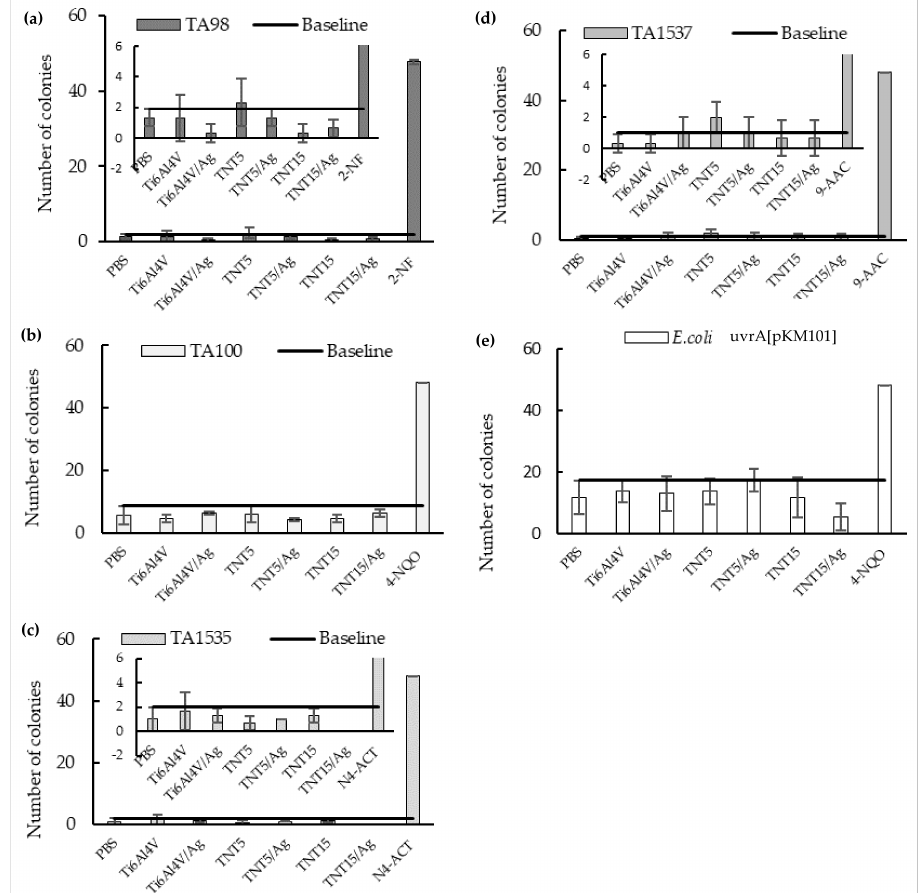
Figure 6. Assessment of implants’ genotoxicity by the Ames assay performed in five genetically modified bacteria strains: ( a ) TA98, ( b ) TA100, ( c ) TA1535, ( d ) TA1537, and ( e ) E.coli ; to improve